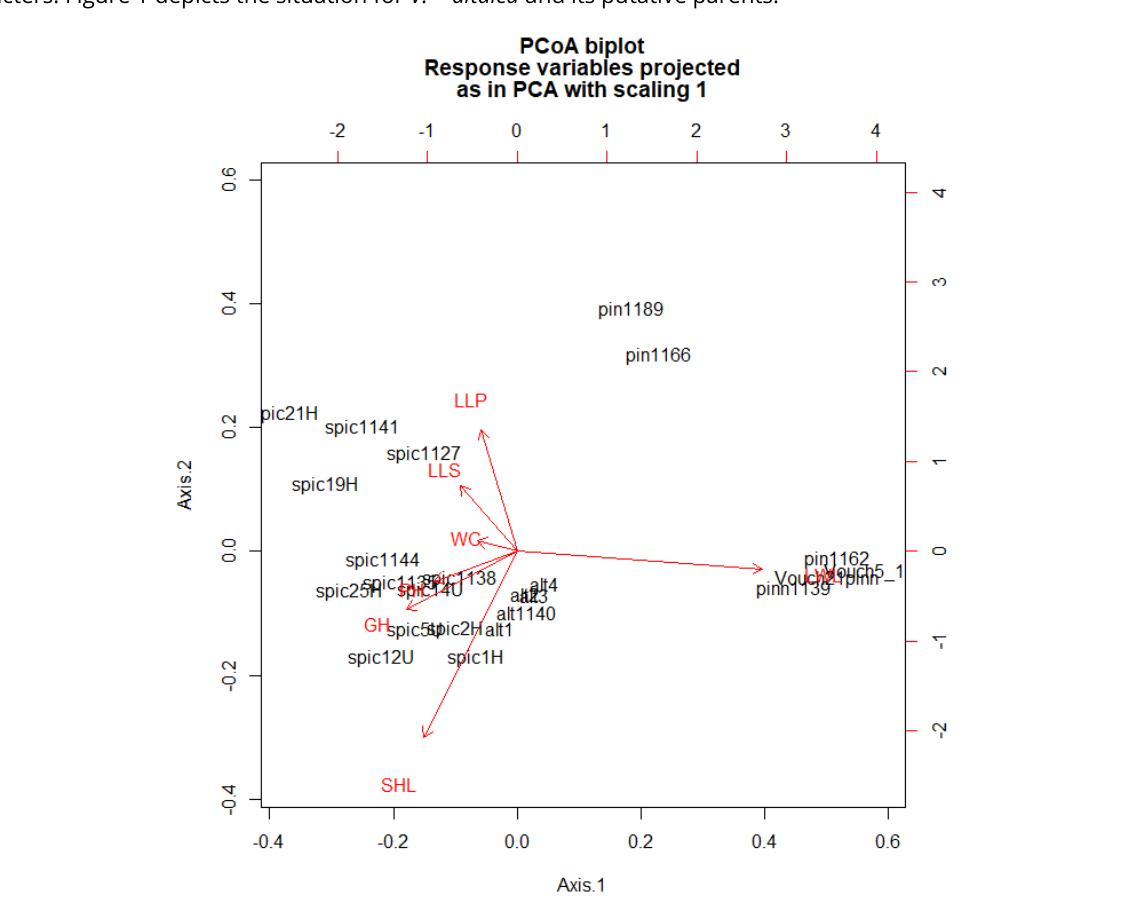
Fig. 1. Principal Co-ordinate Analysis of a matrix of pair-wise Gower distances based on 7 morphological characters scored for 24 individuals from 20 populations of the Veronica × altaica and its putative parents V. spicata and V. pinnata from weastern Altai Mountains and southeastern